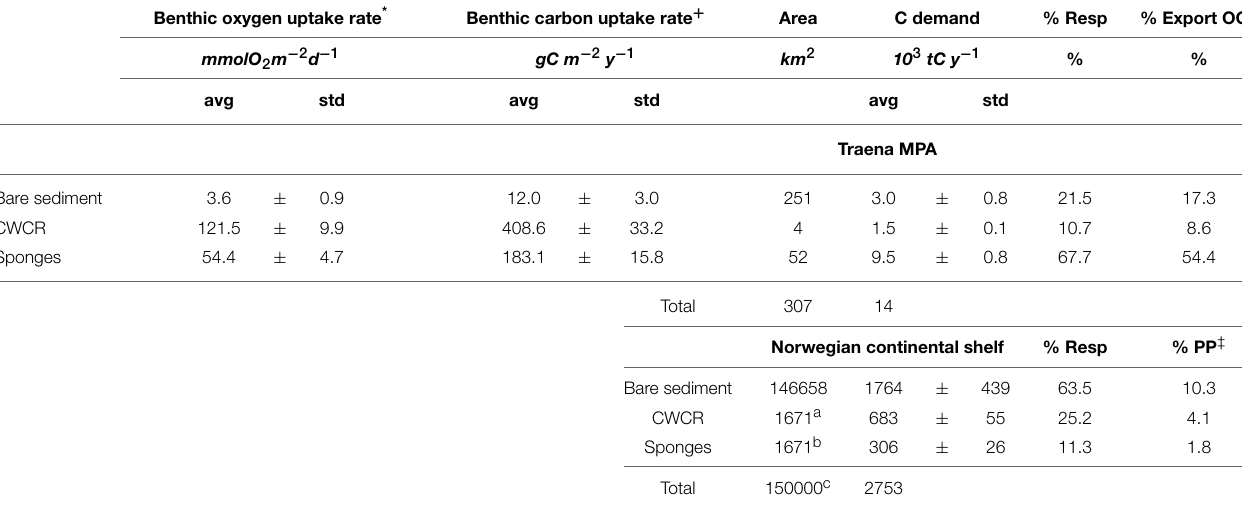
TABLE 5 | Carbon budget over the Traena Marine Protected Area (MPA), and the Norwegian Continental Shelf. Benthic oxygen uptake rate * Benthic carbon uptake rate +